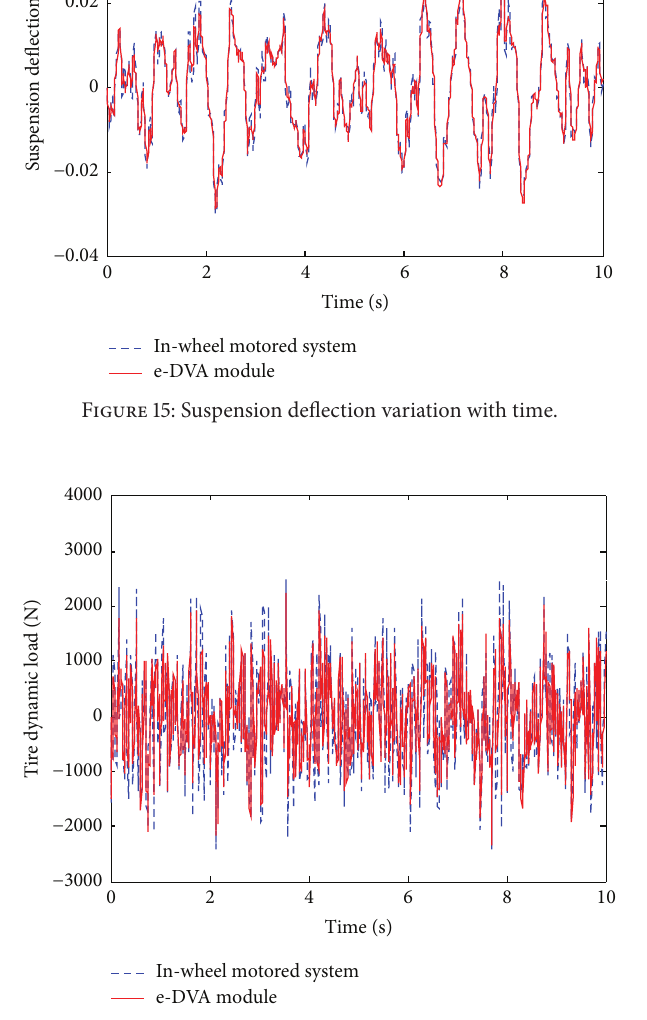
Figure 16: Tire dynamic load variation with time.